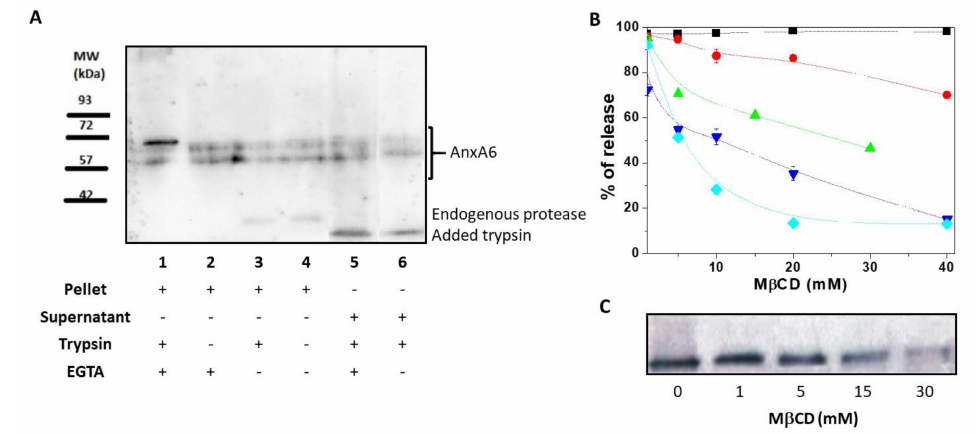
Figure 1. Annexin A6 in matrix vesicles. ( A ) Western blotting performed using mouse anti-AnxA6 monoclonal antibody to detect two isoforms of annexin A6 (AnxA6) in matrix vesicles (MVs) in the presence or absence of 0.1% trypsin after four freeze-thaw procedures followed by centrifugation. Lanes 1, 2, 3, and 4 corresponded to pellets, while lanes 5 and 6 corresponded to supernatants. MVs were treated with or without trypsin, with 2 mM Ca 2 + or with 2 mM ethylene glycol tetraacetic acid (EGTA), as indicated. ( B ) AnxA6 co-localizes with cholesterol. MVs were incubated in synthetic cartilage lymph (SCL) medium containing 10 mM EGTA and an increasing concentration of methyl- β -cyclodextrin (M β CD)for30mininroomtemperature. Then, thesampleswerecentrifuged. Lactatedehydrogenase( (cid:72) ) and tissue non-specific alkaline phosphatase (TNAP) ( • ) activities were tested in the pellets and in the supernatants, as described in Materials and Methods. In the pellets, only the content of cholesterol ( (cid:7) ) and protein ( (cid:4) ) was measured. M β CD-treated pellets were analyzed to determine AnxA6 ( (cid:78) ) content by Western blotting using a rabbit polyclonal anti-AnxA6 antibody that recognizes a single protein band. ( C ) Increasing M β CD concentrations led to a decrease of AnxA6 content. The results are expressed as a percentage of release of MV components ±